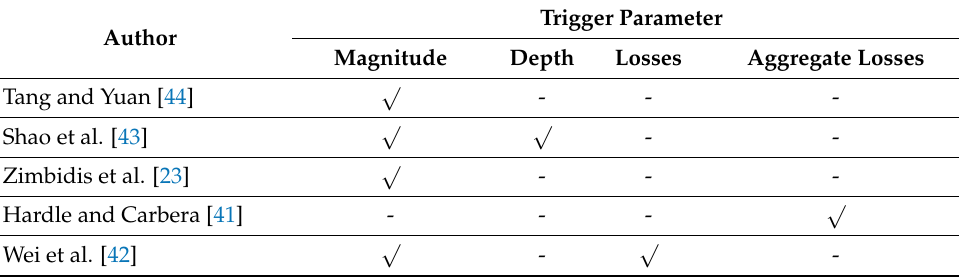
Table 6. Summary of the trigger parameters used in primary